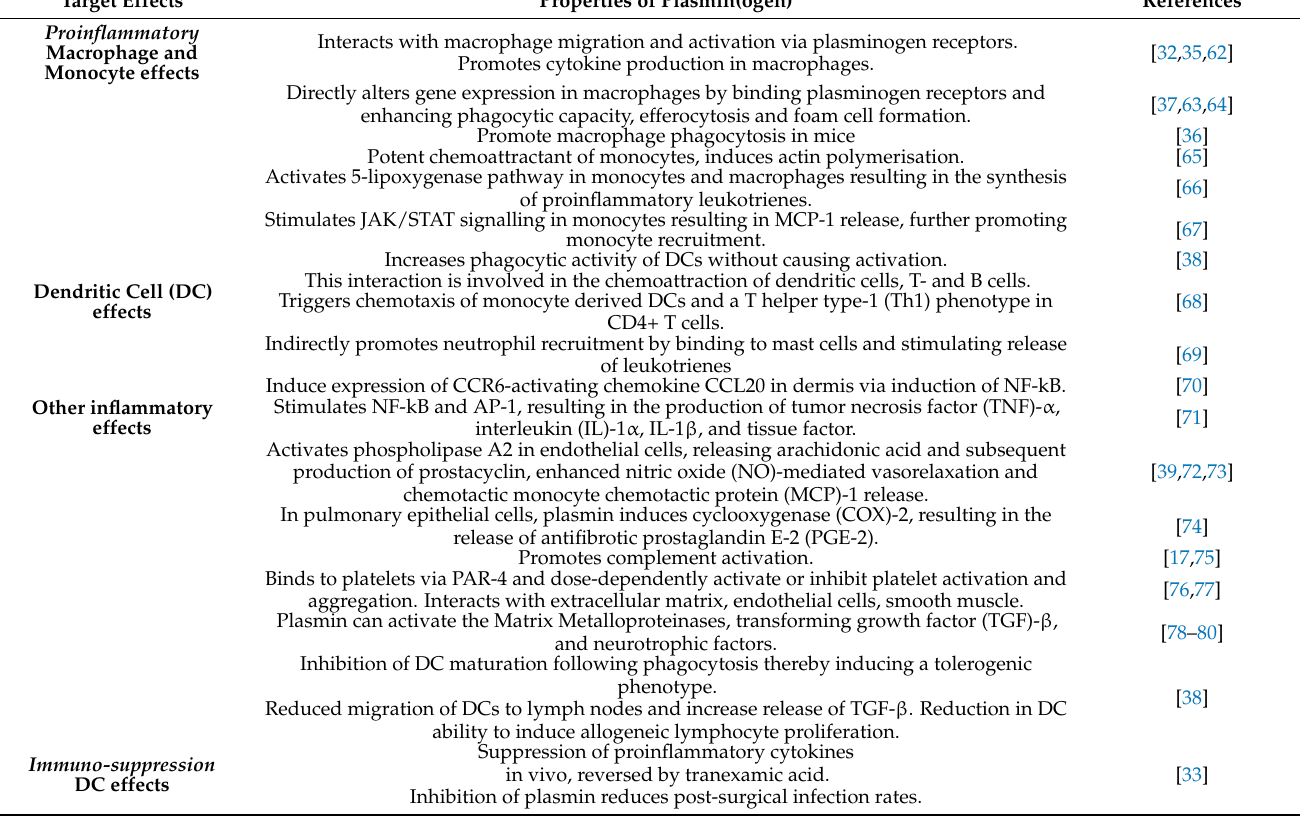
Table 1. Properties of plasmin(ogen) in inflammation and